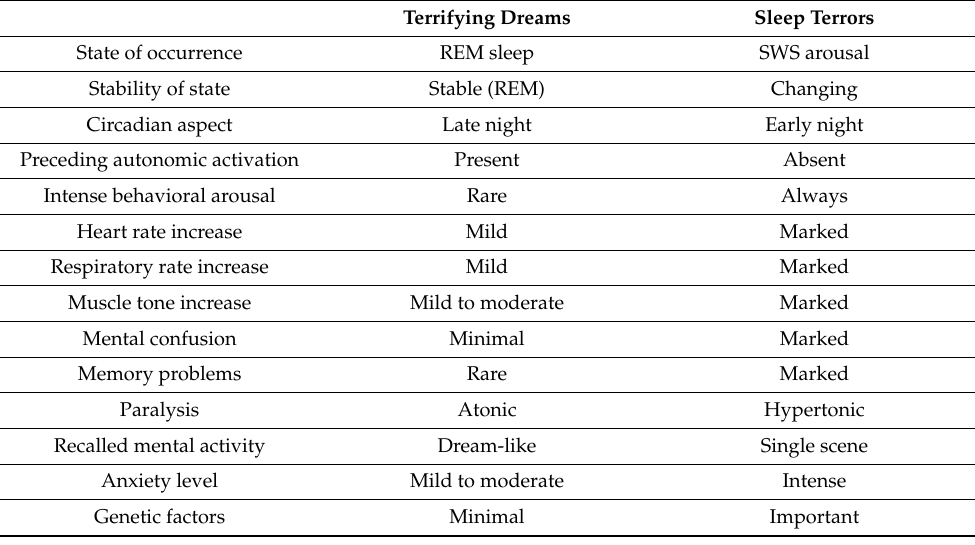
Table 2. A comparison of the differences between the terrifying dreams of REM sleep and sleep